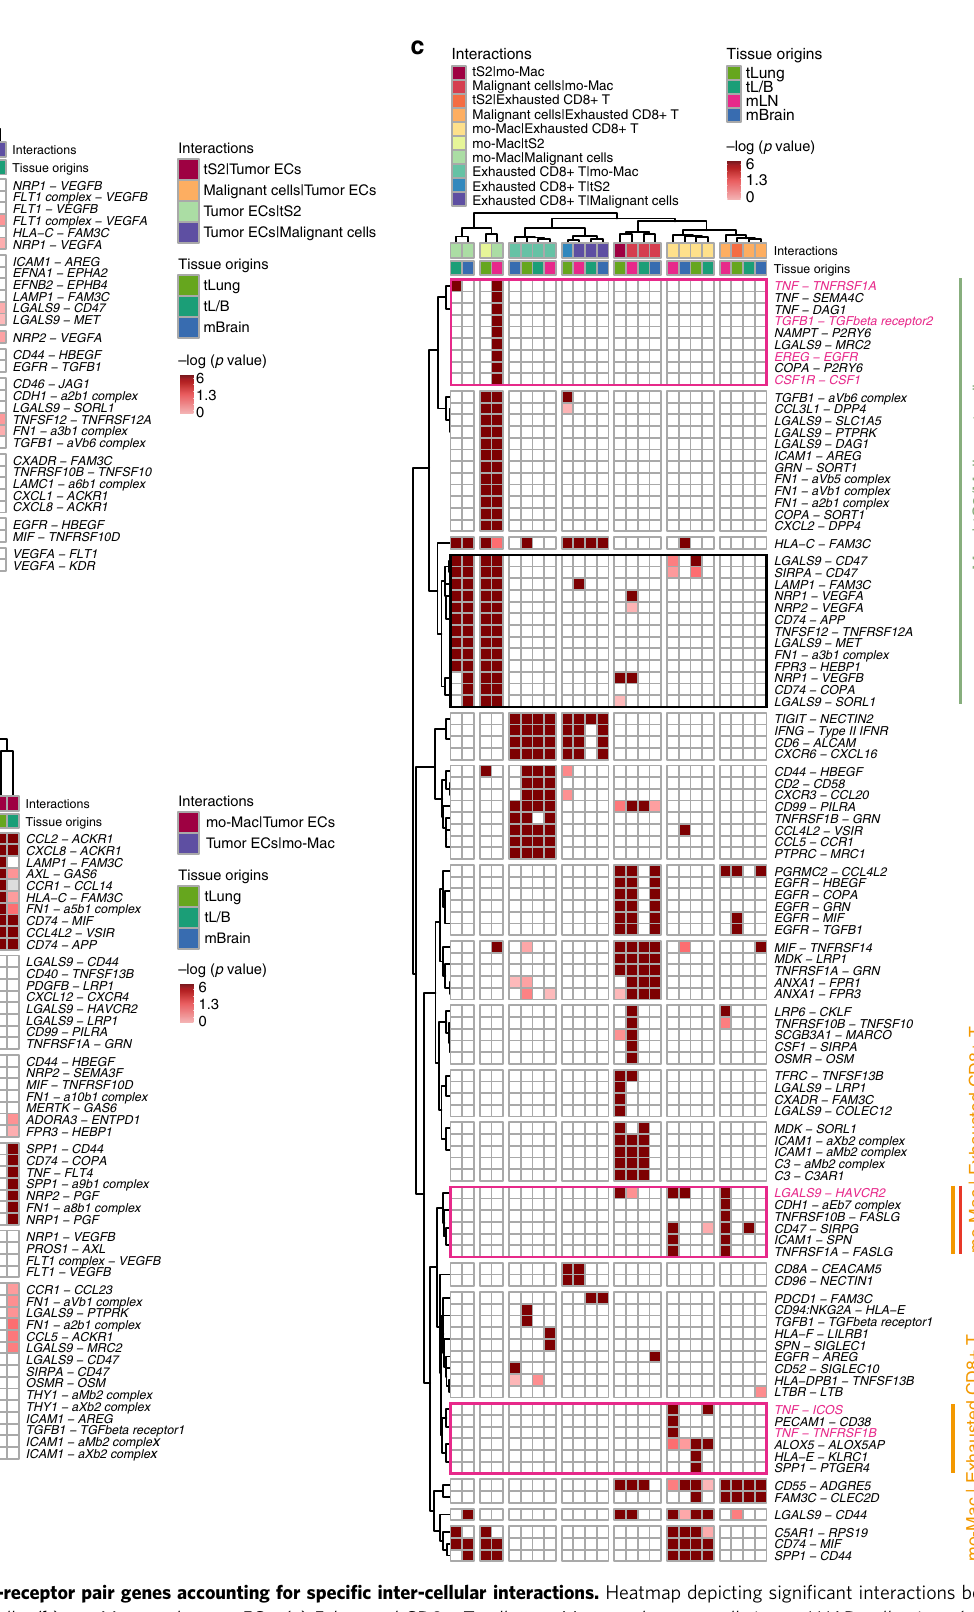
Fig. 7 Signi fi cant ligand-receptor pair genes accounting for speci fi c inter-cellular interactions. Heatmap depicting signi fi cant interactions between ( a ) Tumor ECs and cancer cells; ( b ) mo-Macs and tumor ECs; ( c ) Exhausted CD8 + T cells, mo-Macs, and cancer cells in our LUAD collections (tS2 in tLung and malignant cells in tL/B, mLN, and mBrain). One-sided p-value is calculated from permutation